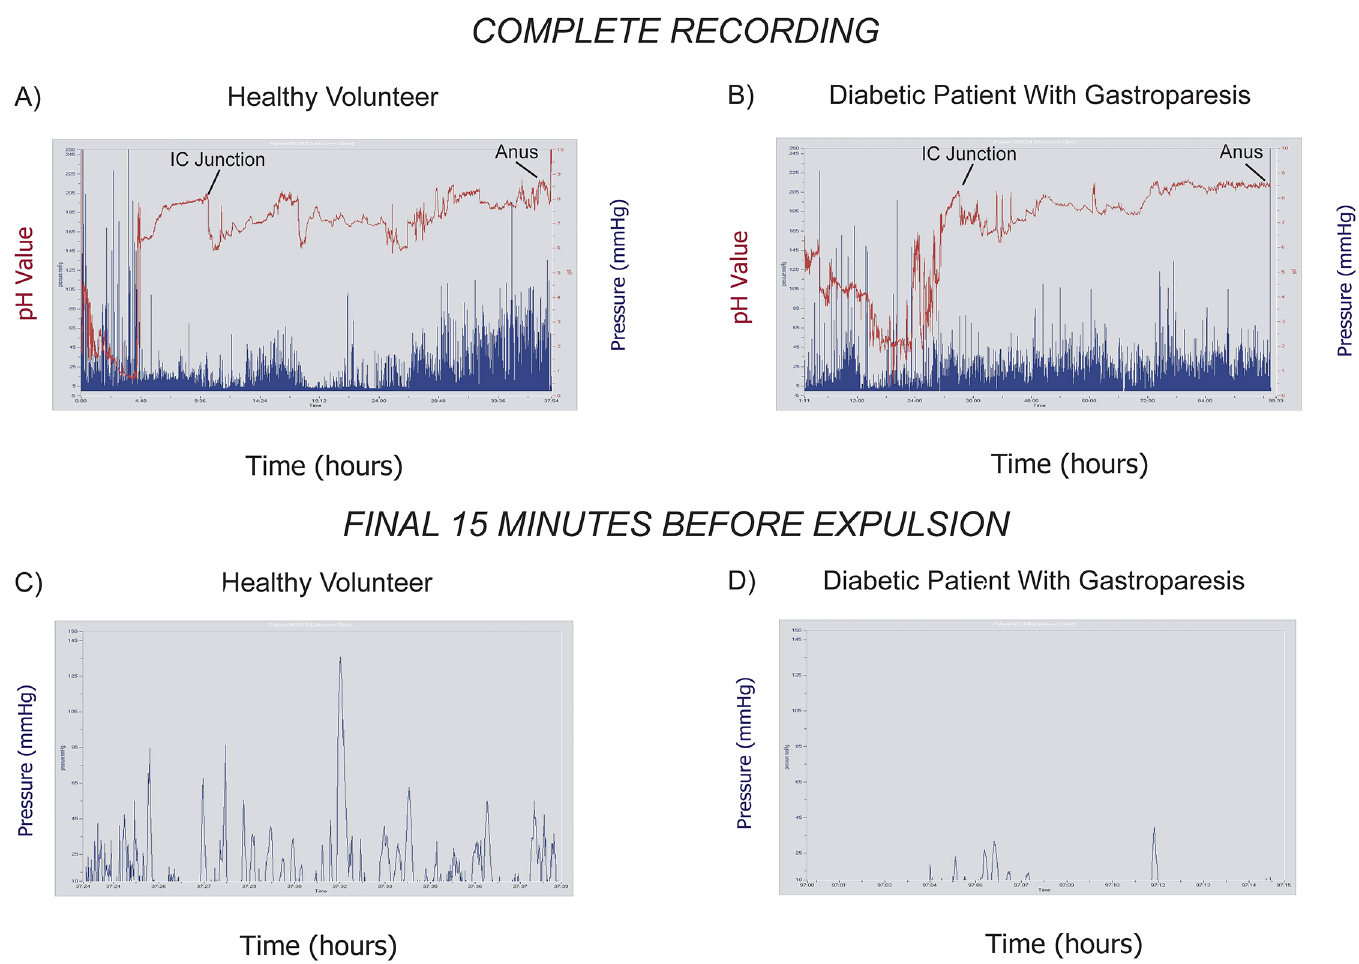
Fig 1. Representative WMC Recordings. Representative WMC recordings are shown from a healthy volunteer (A, C) and a diabetic with gastroparesis (B, D). In the complete recording from the healthy subject, there is an abrupt pH decrease (red) at 10 hours and 15 minutes reflecting ileocecal (IC) transit (A). The capsule is expelled at 37 hours and 39 minutes. In the diabetic, IC transit occurs at 33 hours and 15 minutes and the capsule is expelled at 97 hours and 14 minutes (B). Pressure activity (blue) increases prior to WMC expulsion in the healthy subject, but not in the diabetic with gastroparesis. In the final 15 minutes of colon transit, contractions (blue) are frequent and intense in the healthy volunteer (C) but are reduced in the diabetic